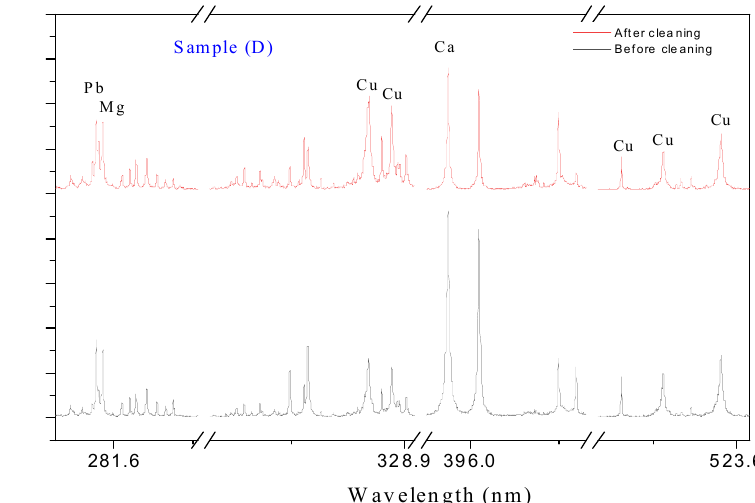
Figure 8. The LIBS spectra of the corroded coin sample (D) before and after cleaning.